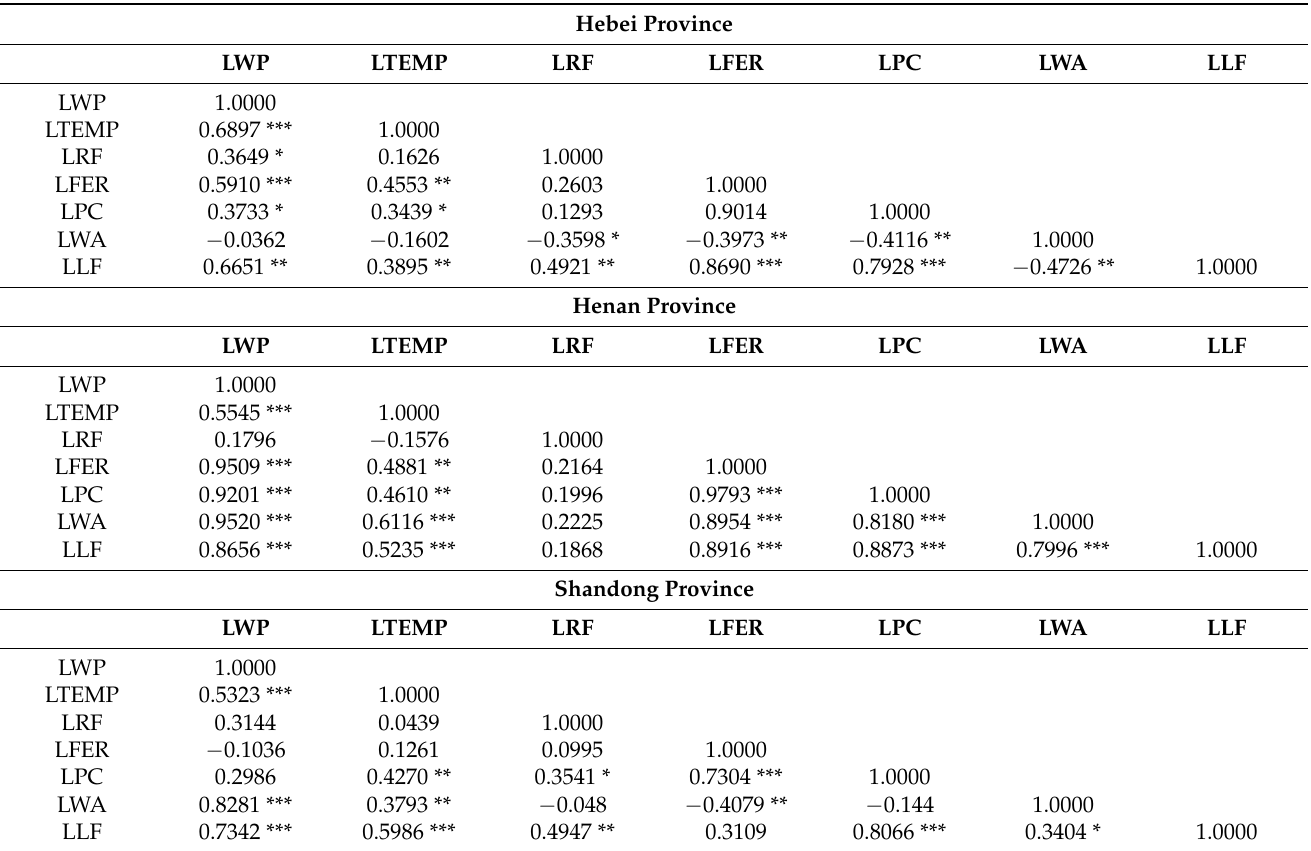
Table 2. Results of the correlation matrix for Hebei, Henan, and Shandong Provinces.